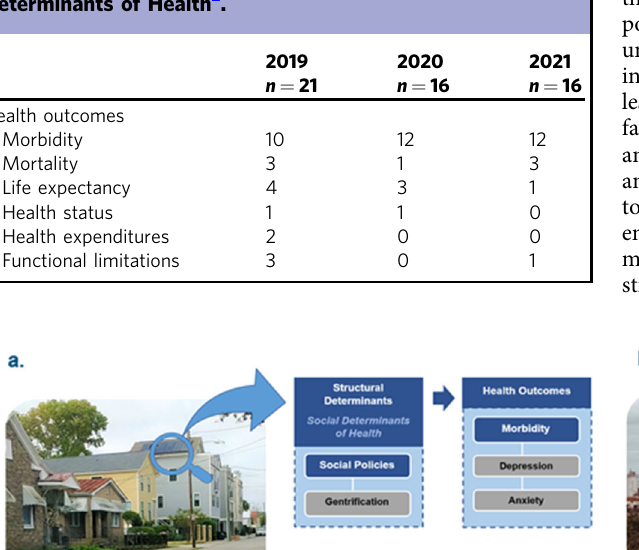
Table 2 Students ’ Chosen Health Outcomes related to Social Determinants of Health 2 .